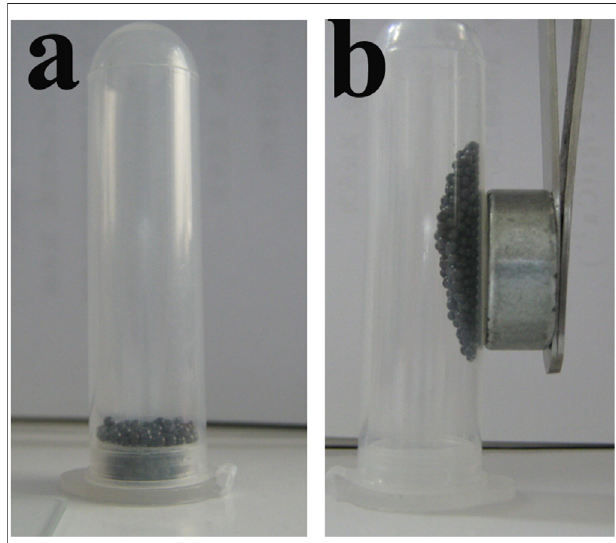
FIGURE 11 | Optical photographs showing magnetic property: (A) PS/ Fe 3 O 4 beadsand (B) thedirectedmovementunderanexternalmagnetic fi eld.